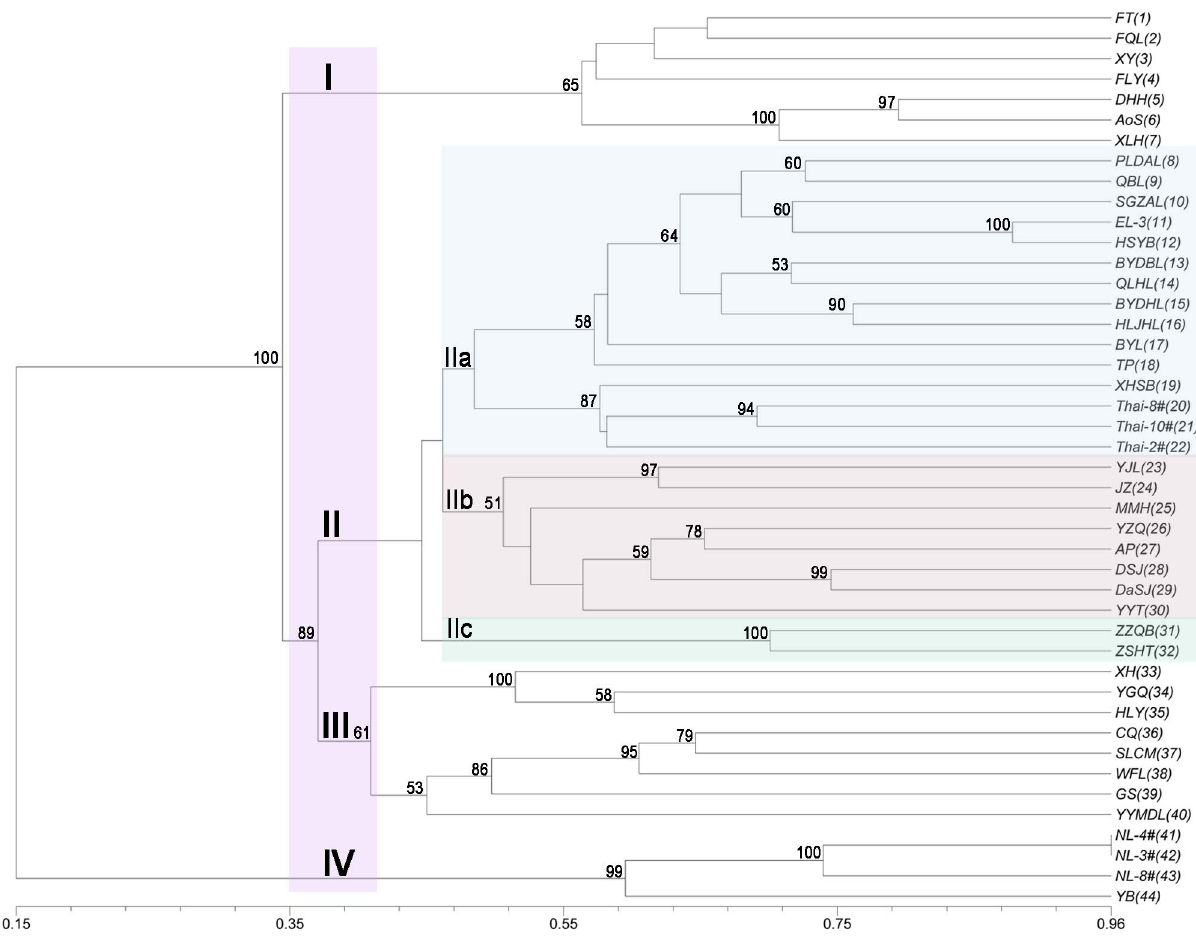
Figure 6. Genetic diversity analysis among Nelumbo accessions based on genic SSR markers. The dendrogram shows the genetic relationships among 44 accessions of Nelumbo . Scale at the bottom of the dendrogram indicates the level of similarity between the genotypes and the numbers on the nodes are bootstrap values ( . 50%) from 1000 replicates.